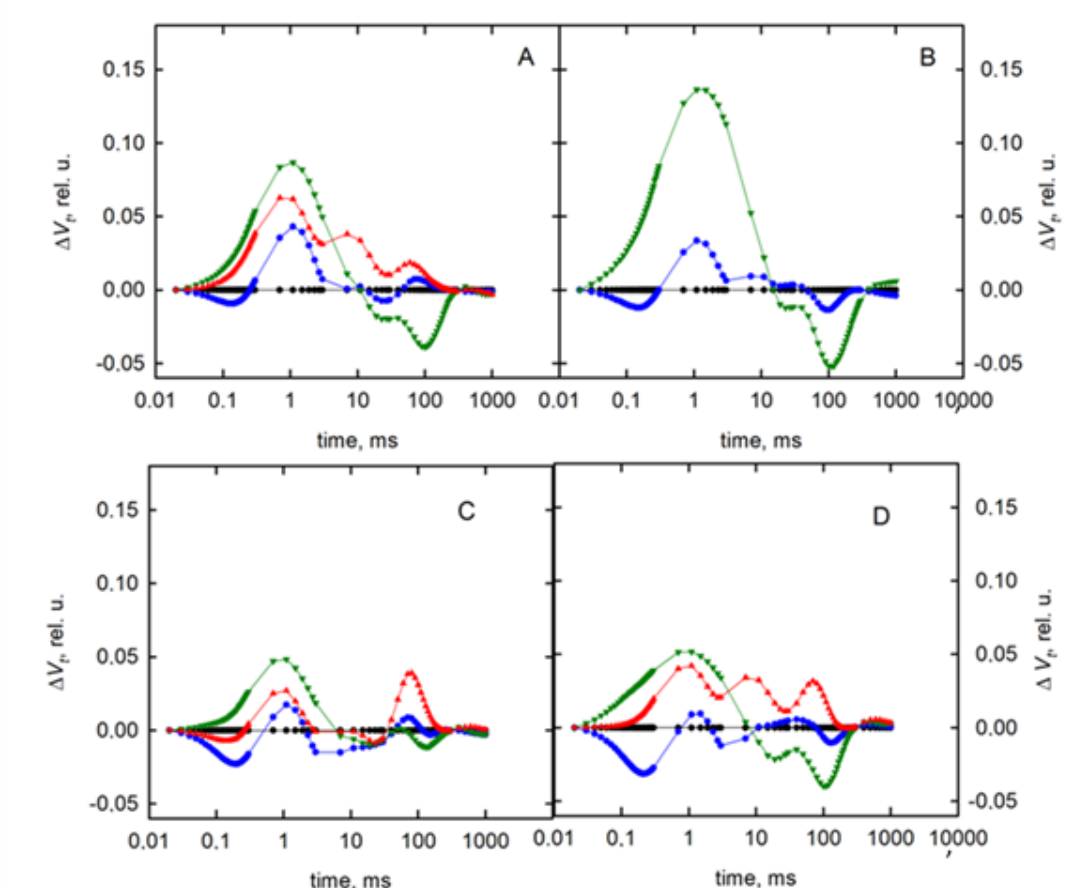
Figure 2. Di ff erential curves of ∆ V t (obtained by subtracting the control curve from the first sample) of perennial ryegrass varieties (Roadrunner and Nira) under di ff erent field water capacities of soil (50 and 30% FWC) and times (0, 120, 240, and 400 h after stress application): ( A ) Roadrunner under 50% FWC, ( B ) Roadrunner under 30% FWC, ( C ) Nira under 50% FWC, ( D ) Nira under 30% FWC. n = 6 relative